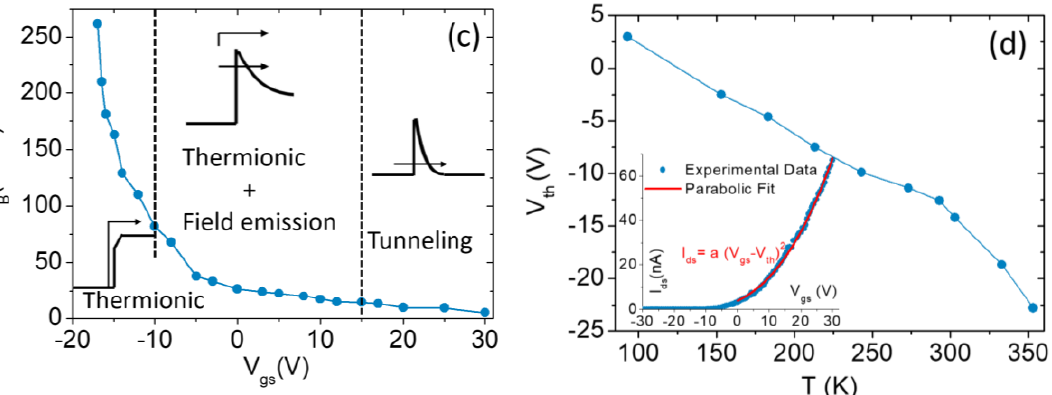
Figure 5. ( a ) Transfer characteristic at several temperatures. ( b ) Arrhenius plot of the current at different temperatures corresponding to a subset of the gate voltages (two of these V gs values are represented by the vertical lines in ( a )). ( c ) Apparent Schottky barrier as a function of the gate voltage; the insets show the band alignment and the transport regimes at the Ni/WSe 2 reverse-biased contact. ( d ) Threshold voltage V th as a function of the temperature; the inset shows, as an example, the parabolic fit of the I ds − V gs curve at T = 273 K .